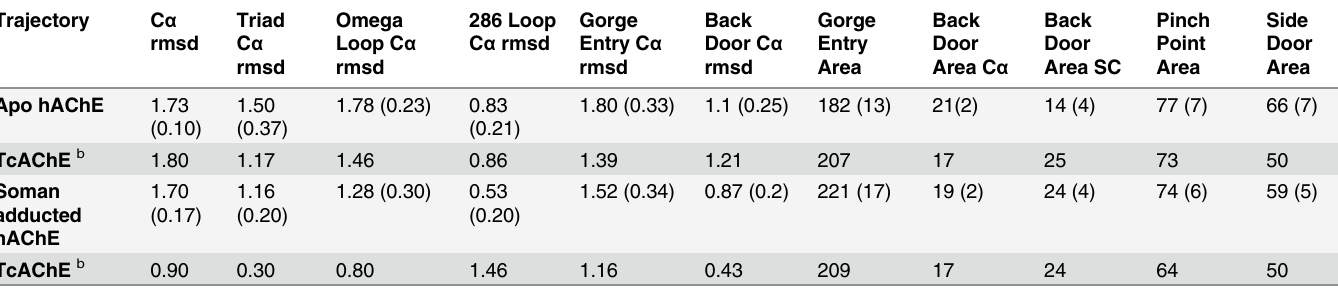
Table 2. C α RMSD values and opening areas for the native and soman-adducted protein MD trajectories. a